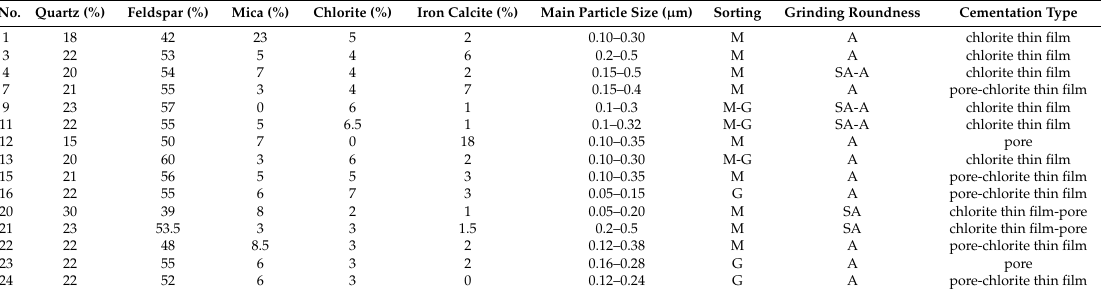
Table 2. The thin section observations of samples.